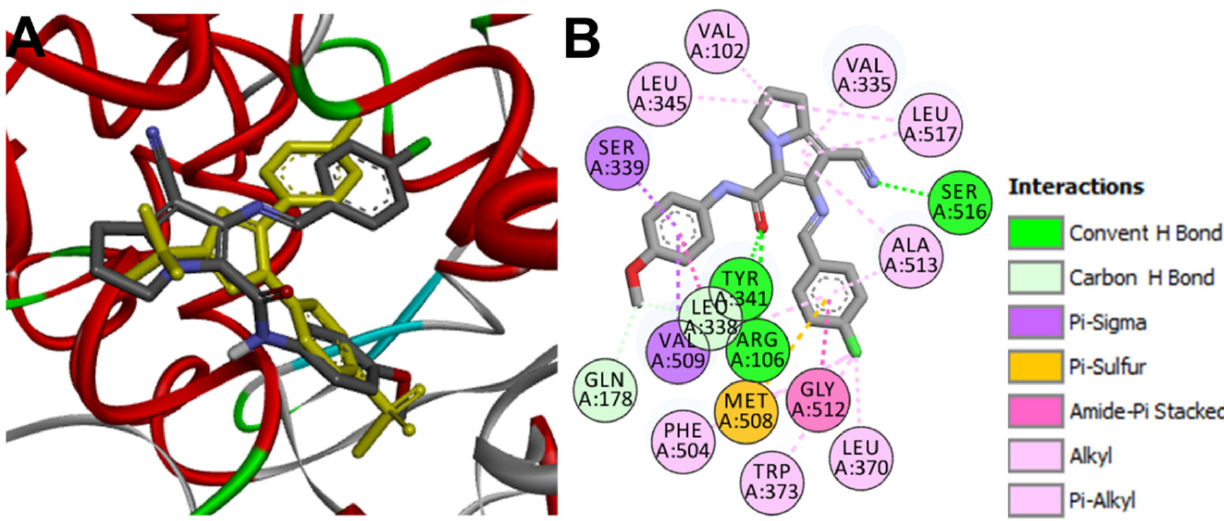
Figure 16. Binding mode of compound 16g (shown as sticks colored by element) into COX-2 (pdb: 3LN1): ( A ) 3D binding mode of compound 16g overlaid with celecoxib (yellow sticks); ( B ) 2D binding mode of compound 16g showing different types of interactions with amino acids in COX-2.